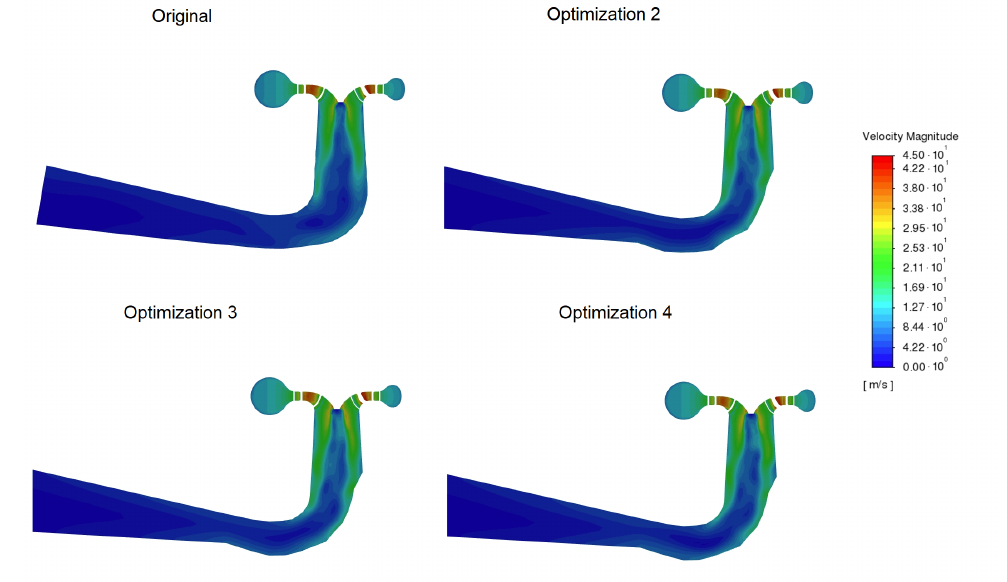
Figure A7. Velocity magnitudes in a longitudinal draft tube cross-section for a 12.8 m 3 /s flow